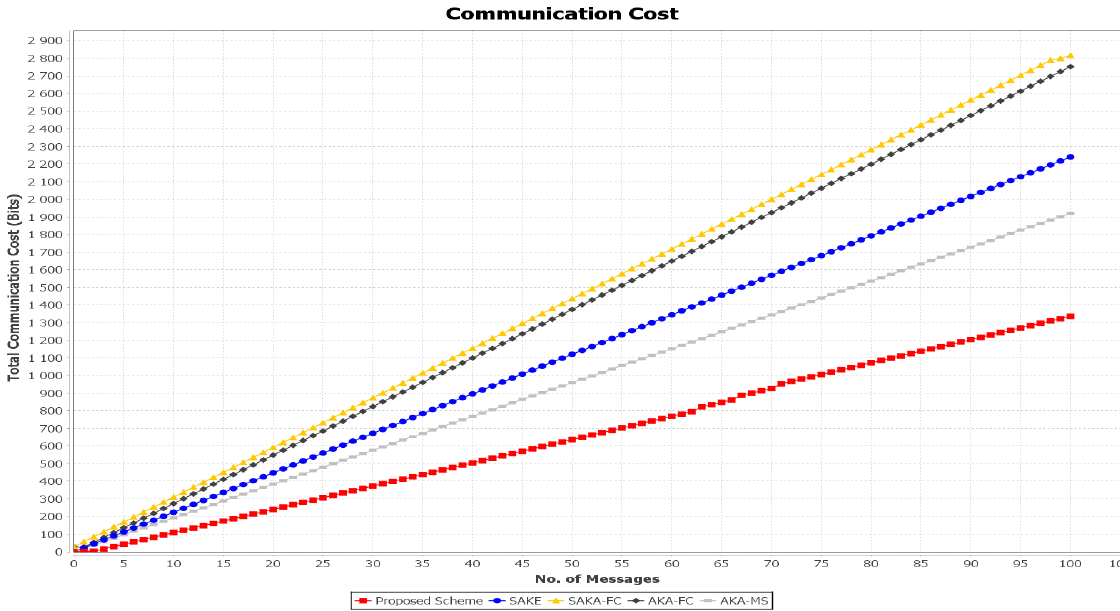
Figure 15. Communication costs comparison of SELAMAT against SAKA-FC, SAKE, AKA-FC, and